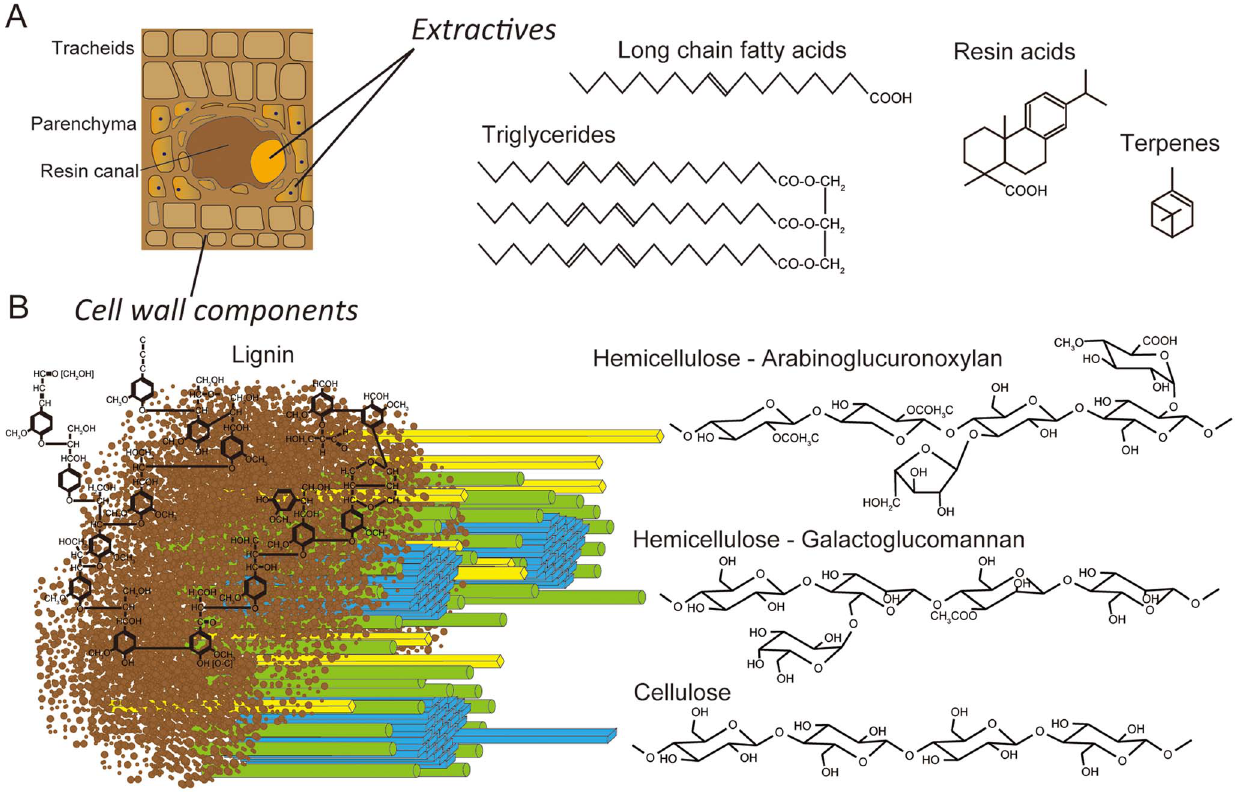
Figure 1. Schematic representations of lignocellulose components in cell walls of pine wood. Panel A: The extractives (long chain fatty acids, triglycerides, resin acids and terpenes) are found primarily in the resin ducts, but damage to pine wood causes the release of these compounds across wounded areas. Panel B: In tracheid cell walls, the amorphous, phenylpropanoid polymer lignin (brown) form a matrix around the more structured carbohydrate polymers, hemicellulose (yellow and green) and cellulose